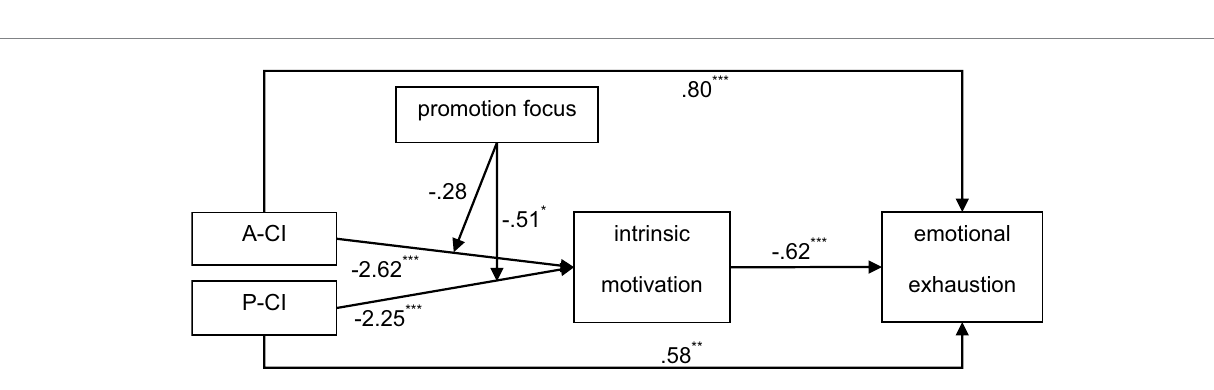
FIGURE 3 Overall results of Study 1. A-CI, Active cyber incivility; P-CI, Passive cyber incivility. * p < 0.05, ** p < 0.01, *** p <